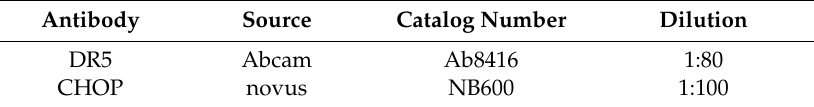
Table 1. Antibodies used for immunohistochemical